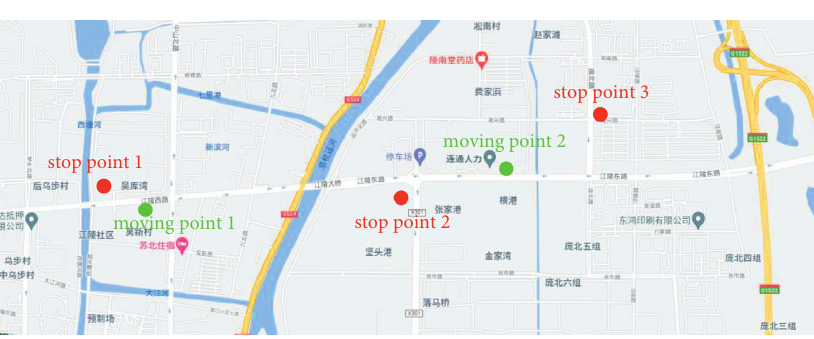
Figure 10: Map matched stop point recognition Figure 10 is the map matching of the stop point recognition result. Stop point 1 is in the subway station.